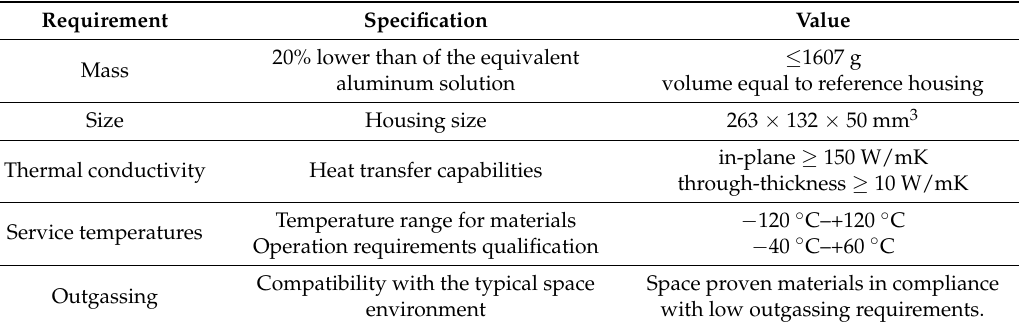
Table 8. Electronic box requirements.